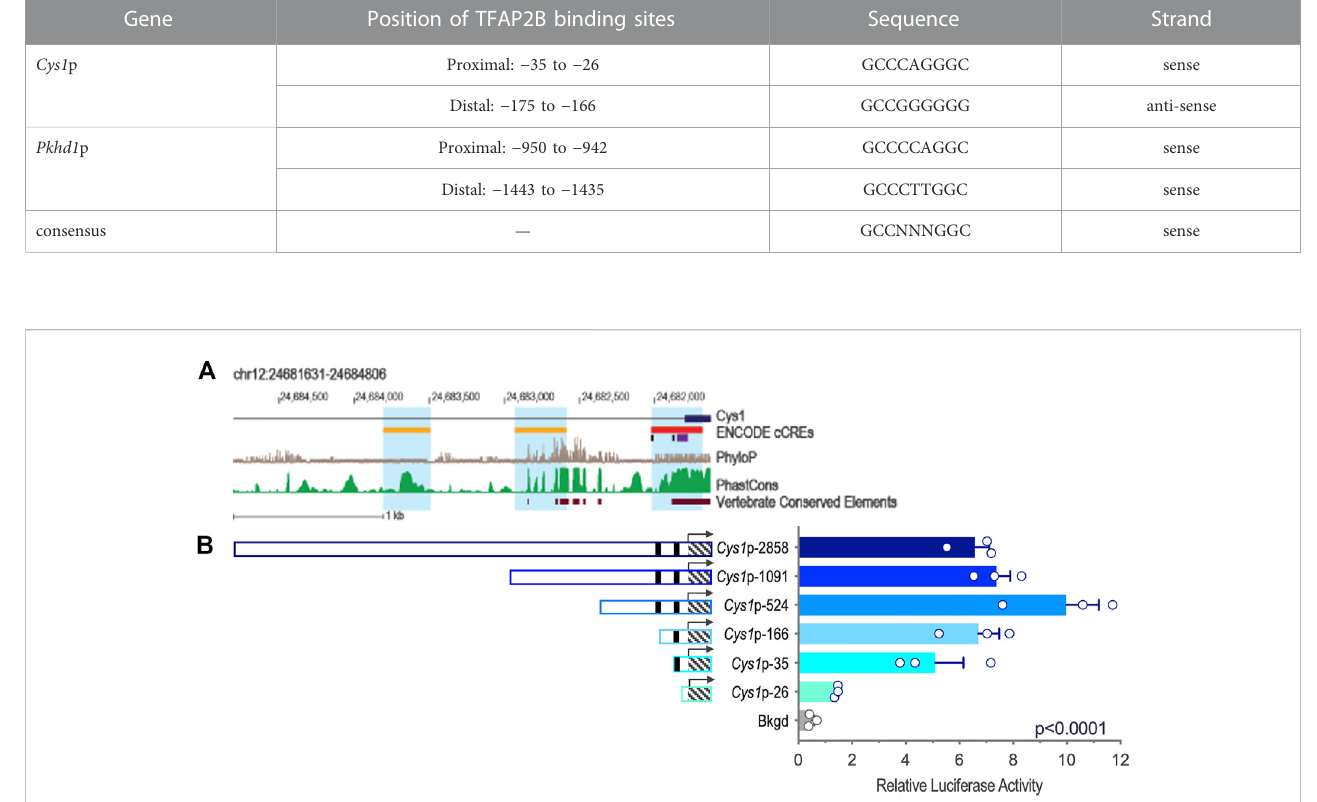
FIGURE 2 Cys1 upstreamregulatoryregionandreportergeneanalysisof Cys1 promoterconstructs. (A) Mapofthe Cys1 upstreamregulatoryregionshowingUCSC tracks for predicted regulatory elements (cCRE and Vertebrate Conserved Elements) and sequence conservation (phyloP and PhastCOns). Black rectangles indicate TFAP2B binding sites. (B) Cys1 promoter constructs and corresponding relative luciferase activities in transfected mIMCD-3 cells. Black rectangles indicate TFAP2B binding sites. Hatched boxes indicate Cys1 5 ′ -UTR sequences. Arrows indicate TSS. The Cys1 TSS genomic coordinate is Chr12: 24,681,806 from the GRCm38/mm10 mouse genome assembly. The error bars indicate S.E.M. One-way ANOVA was used to determine the signi fi cance of differences among mean luciferase activities associated with each